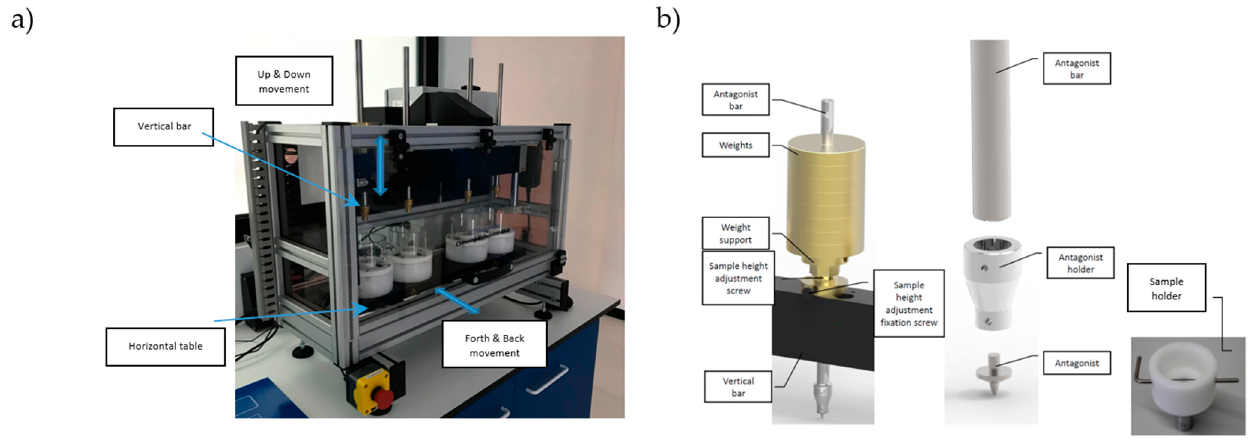
Figure 2. Setup of wear simulations: ( a ) chewing simulator with moving directions, ( b ) antagonist holding system (overview left and detailed view right).